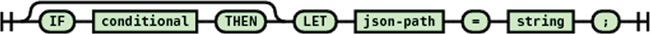
Syntax diagram for constant field transformation statement.